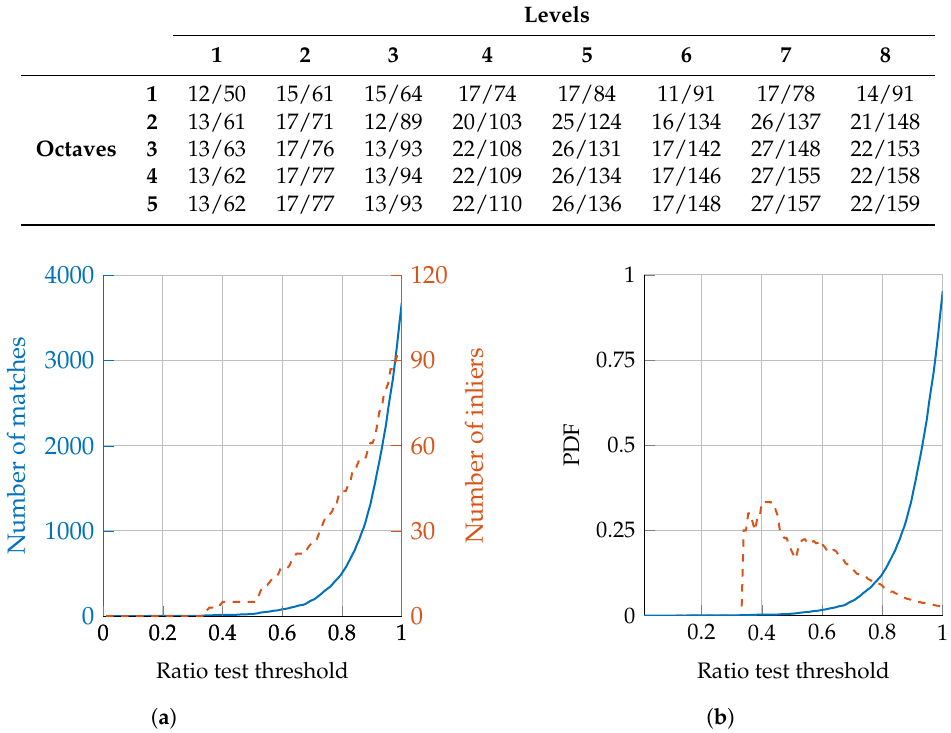
Table 2. Analysis of SIFT performance with different octaves and levels for the Container dataset. Cells contain the number of correct matches (first number) from the set of remaining matches (second number) after applying the ratio test with a fixed threshold of 0.75. Due to the scale adaption of the UAV image, the number of keypoint detections saturates after two octaves. By increasing the levels, more keypoints can be detected, but the ratio of inliers decreases.